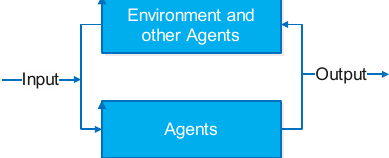
Figure 2. The operational model of the agent